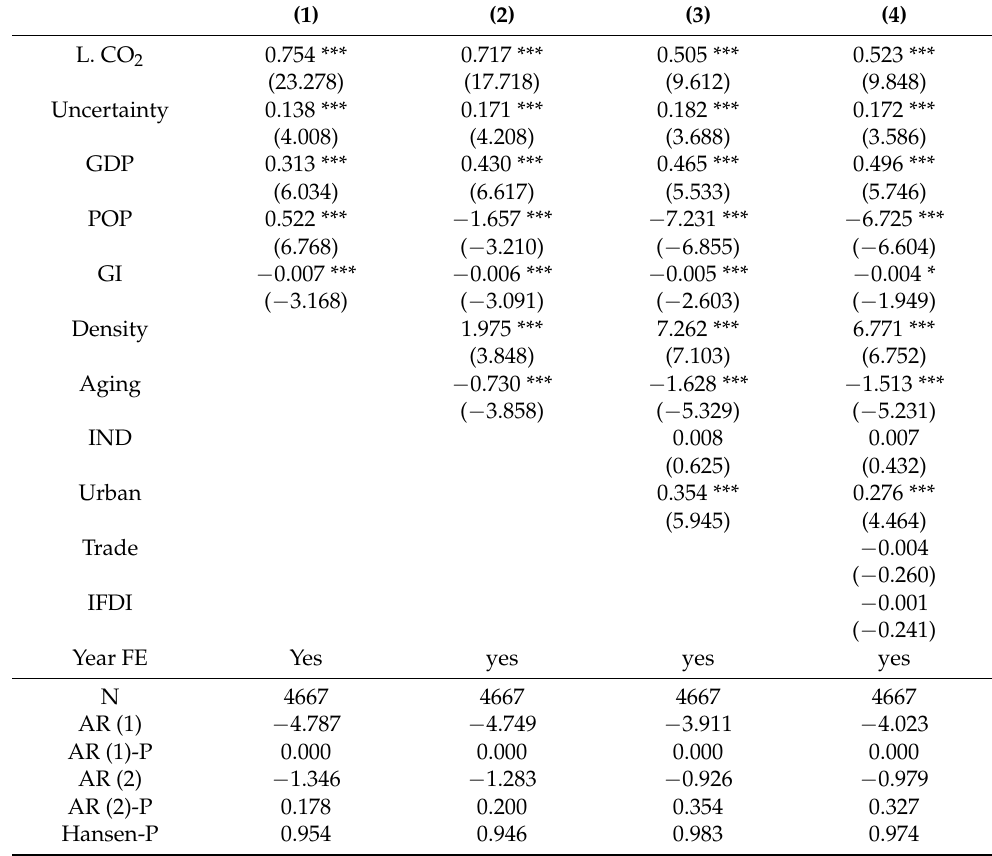
Table 3. SYS-GMM estimations for EPU’s impact on